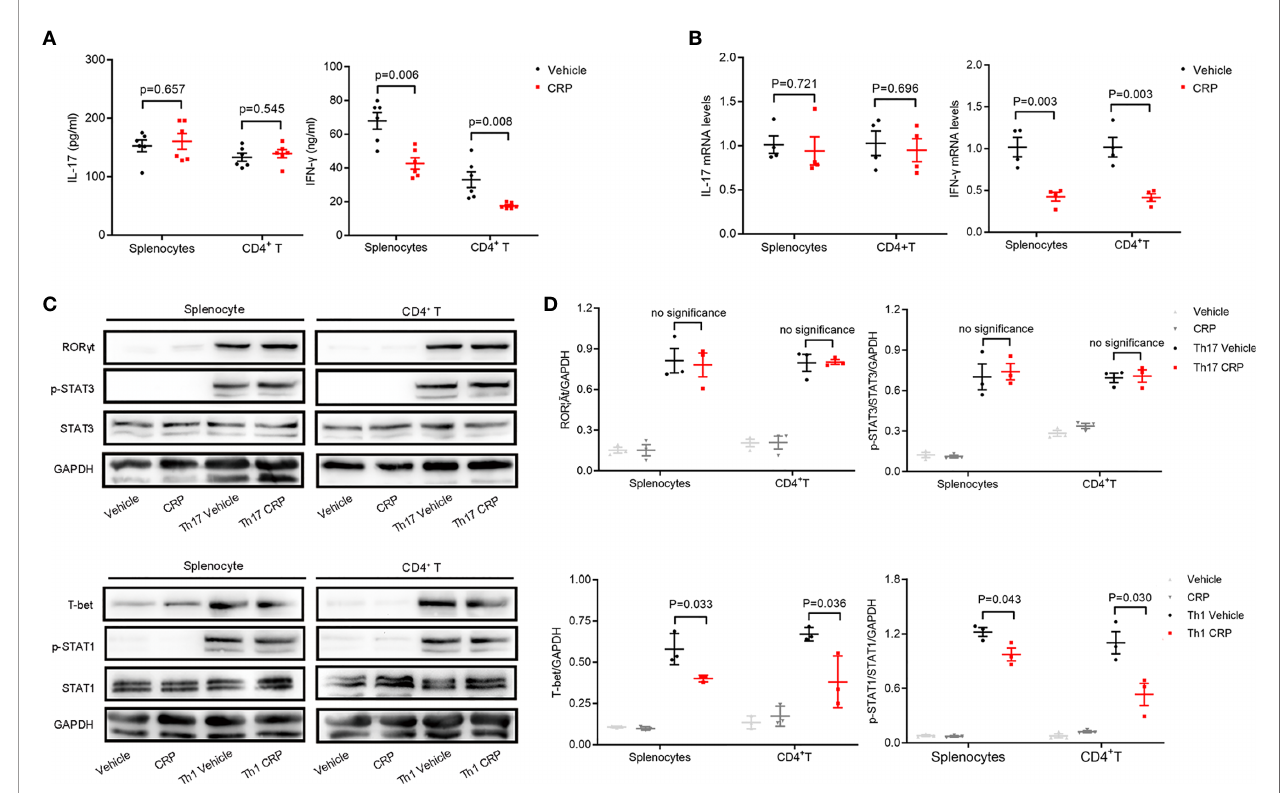
FIGURE 5 | The decrease in Th17 response disappeared in Fc g R2B − / − splenocytes.Splenocytes and CD4 + T cells were isolated from Fc g R2B − / − mice to distinguish the indirect and direct regulations of CRP on Th17. (A) The protein expression levels of IL-17 and IFN- g were measured in Fc g R2B − / − splenocytes and Fc g R2B − / − CD4 + T cells with or without CRP treatment (n = 6). (B) The mRNA expression levels of IL-17 and IFN- g in Fc g R2B − / − splenocytes and Fc g R2B − / − CD4 + T cells with or without CRP treatment (n =4). (C) Fc g R2B − / − splenocytes and Fc g R2B − / − CD4 + T cells were isolated and incubated with or without CRP in Th17 and Th1 polarization condition, then ROR g t, T-bet, p-STAT-3, and p-STAT-1 were detected by WB (n = 3). (D) The quantitative and statistical analysis of the WB results was presented (n = 3). Data are presented as mean ± SEM; p < 0.05 was considered statistically signi fi cant. ns, no signi fi